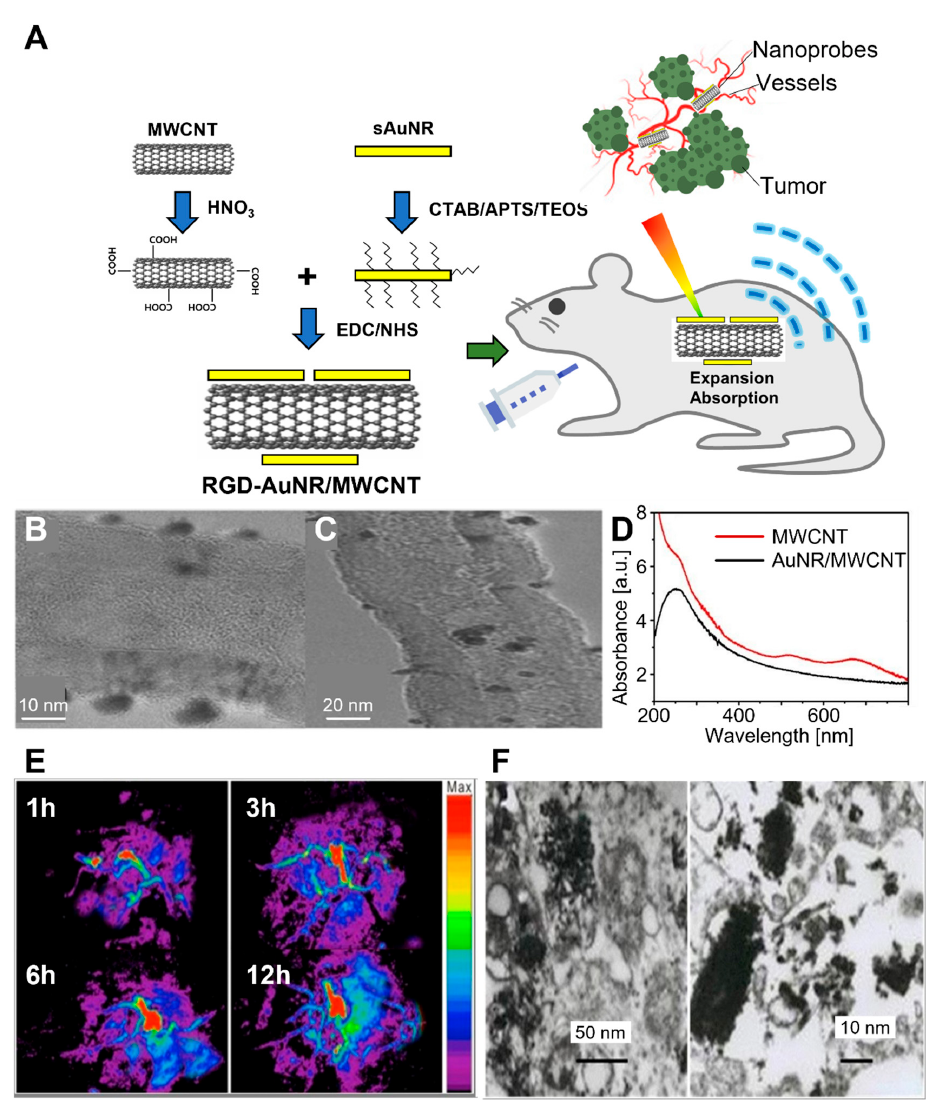
Figure 7. RGD–AuNR/MWCNT conjugate for targeted PAI of gastric cancer. ( A ) Schematic diagram of synthesis and application of RGD–AuNR/MWCNT in mouse gastric cancer vessel visualization. ( B ) TEM and ( C ) HR–TEM images of AuNR/MWCNT. ( D ) UV–vis spectra of pristine MWCNT and AuNR/MWCNT. The inset shows the magnification in the region of 400~800 nm. ( E ) Photoacoustic images of different post-injection times. ( F ) TEM images of RGD–AuNR/MWCNT inside the MGC803 cells. The images are reproduced with permission from ref.